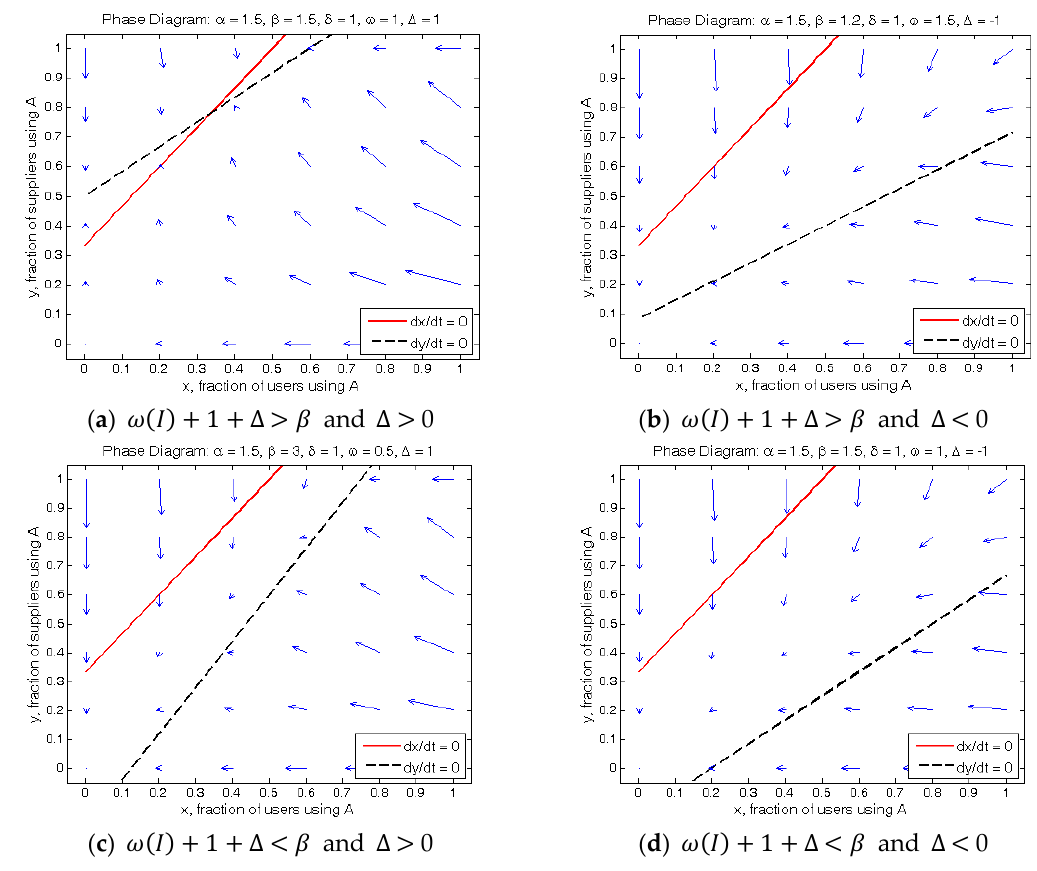
Figure 2. Various patterns of dynamics in the state space.